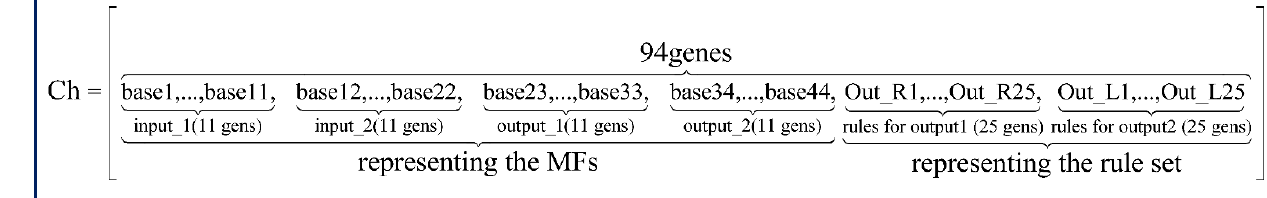
Figure 10. Representation of each chromosome.